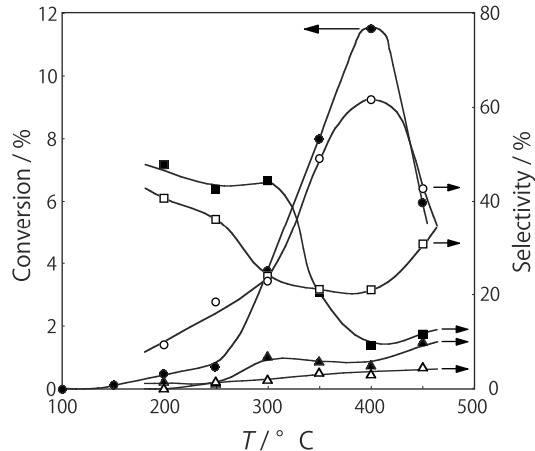
Figure 17. Effect of temperature on the reaction of pyridine with methanol over (H O) [(W Cl )Cl ]·6H O/SiO . Following the activation of the supported cluster (200 mg, 3 2 6 8 6 2 2 5.7 μmol) in a hydrogen stream (300 mL/h) for 1 h, reaction was initiated by introduction of pyridine (20 μL/h, 0.25 mmol/h) and methanol (203 μL/h, 5.0 mmol/h) to the stream without changing the temperature. Conversion and selectivities are based on pyridine at 3 h after the start of the reaction. Conversion of pyridine (●); selectivity for 2-methylpyridine (○); selectivity for 3-methylpyridine (■); selectivity for 4-methylpyridine (□); selectivity for dimethylpyridines (∆); and selectivity for ethylpyridines